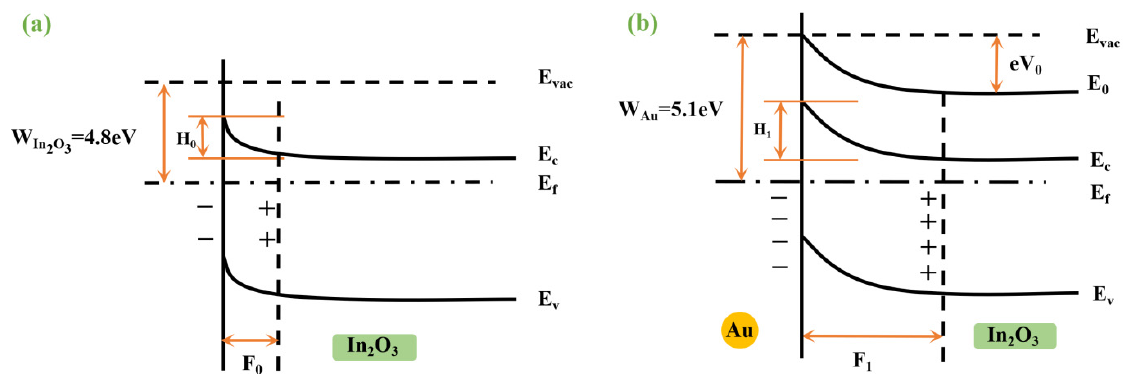
Figure 8. Energy level diagrams of ( a ) pure In 2 O 3 and ( b ) Au/La-In 2 O 3 in air.